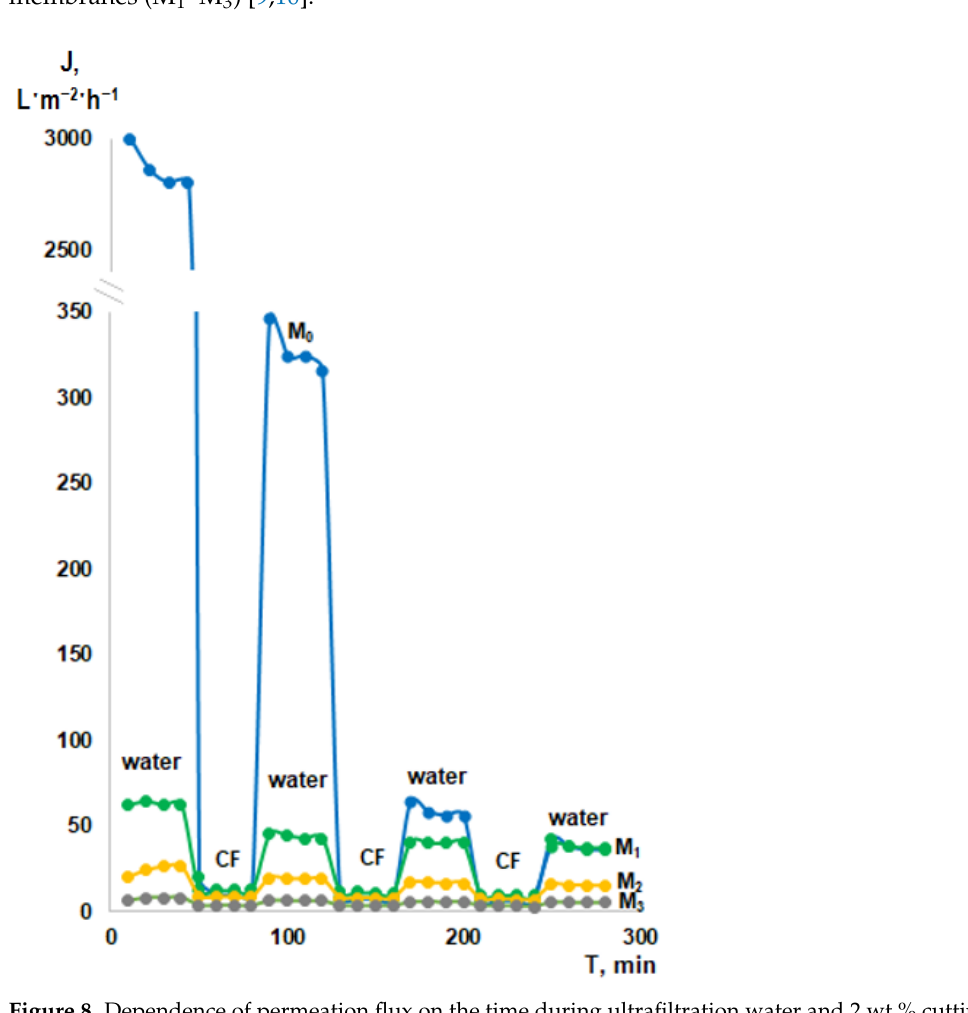
Figure 8. Dependence of permeation flux on the time during ultrafiltration water and 2 wt.% cutting fluid emulsion.